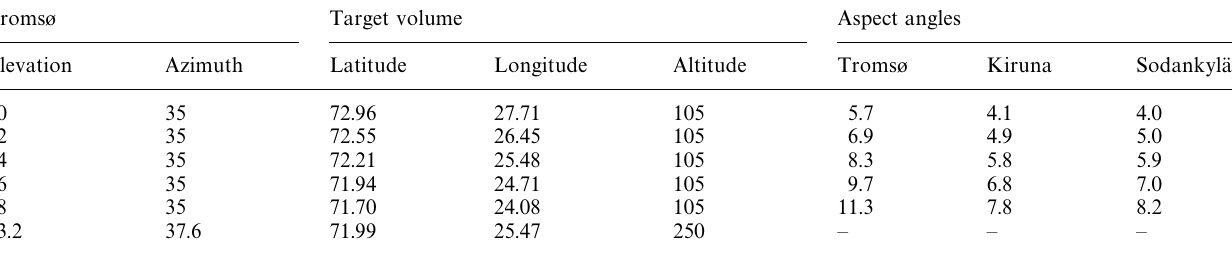
Table 1. Target locations and aspect angles